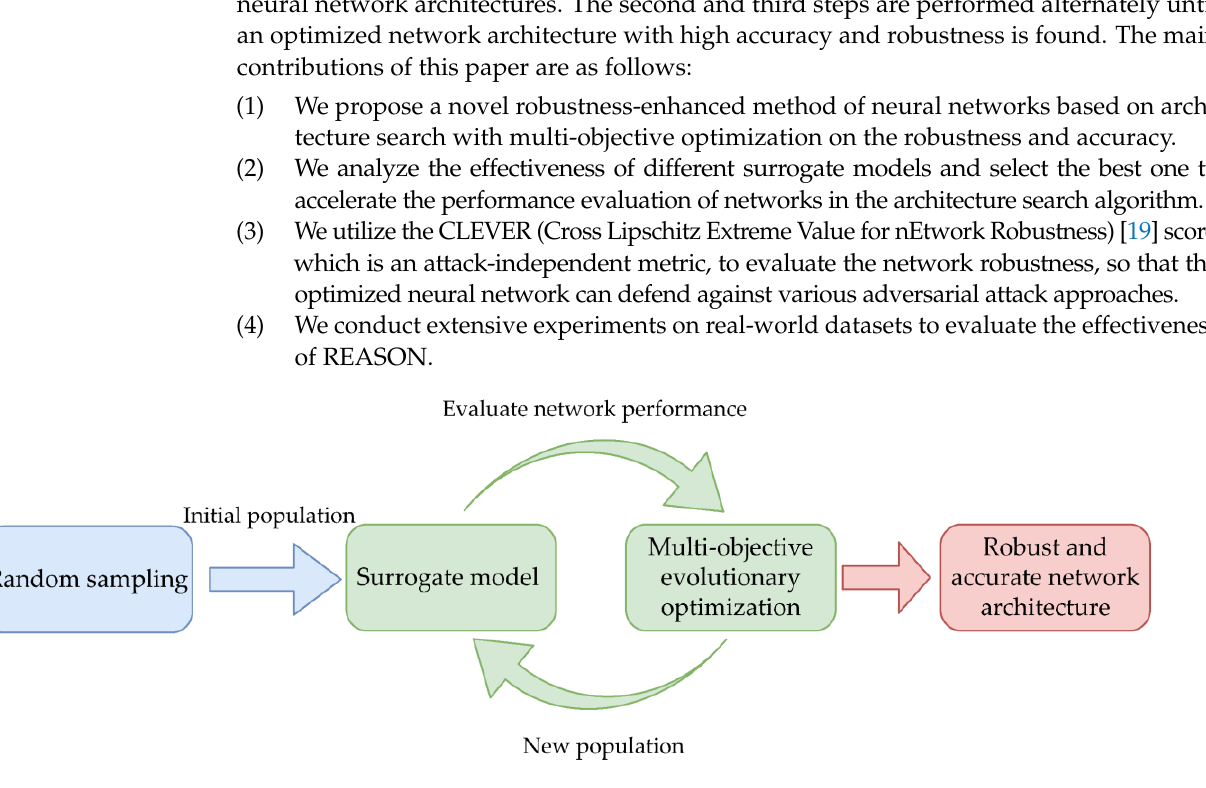
Figure 1. The overall process of the proposed method.